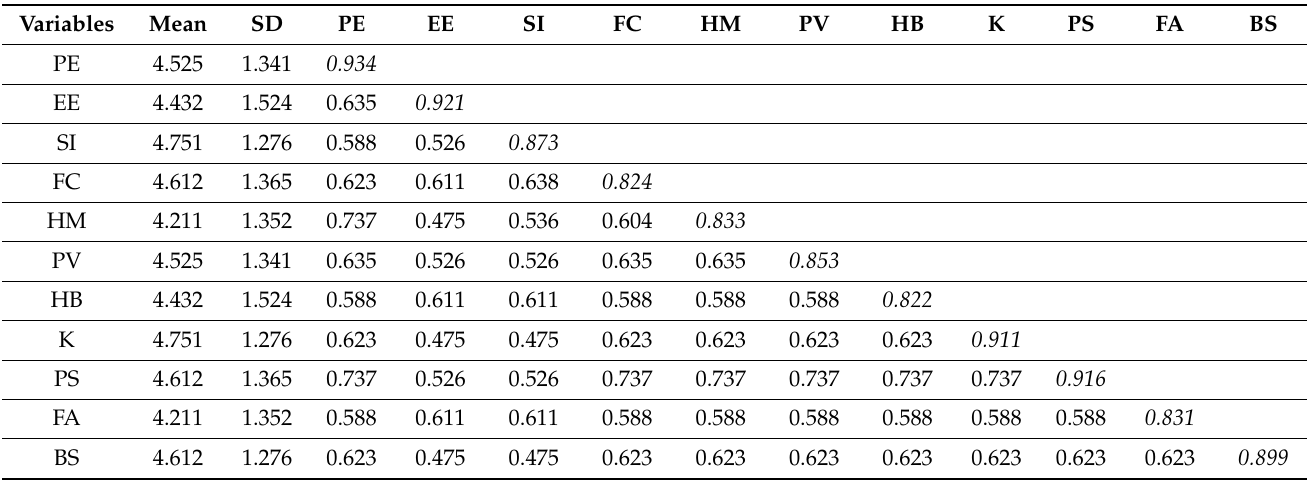
Table 3. Discriminant validity.